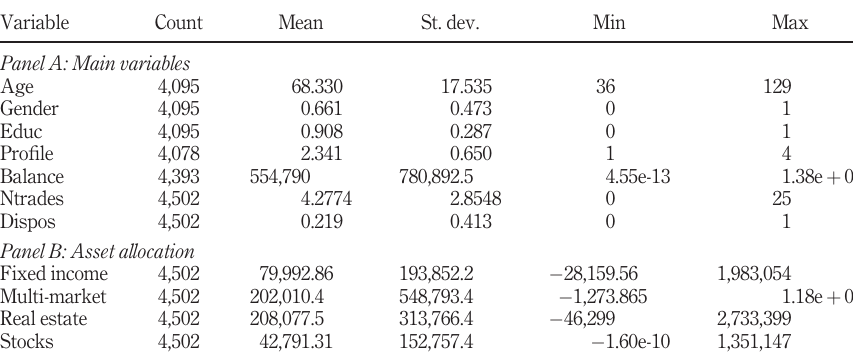
Table 1. Investor pro fi